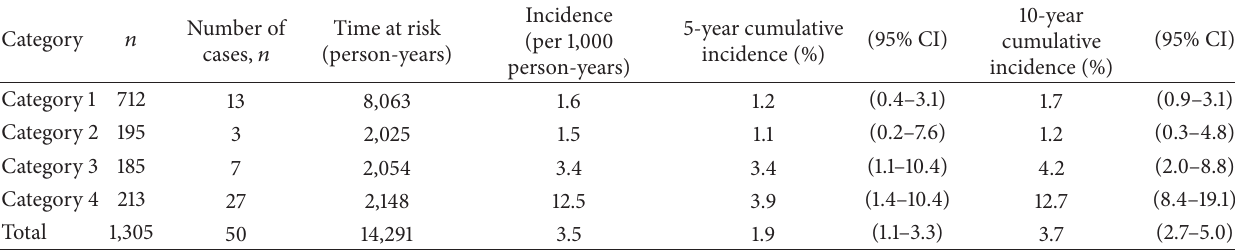
Table 2: Diabetic foot ulcer incidence according to the microangiopathy complications category at baseline.